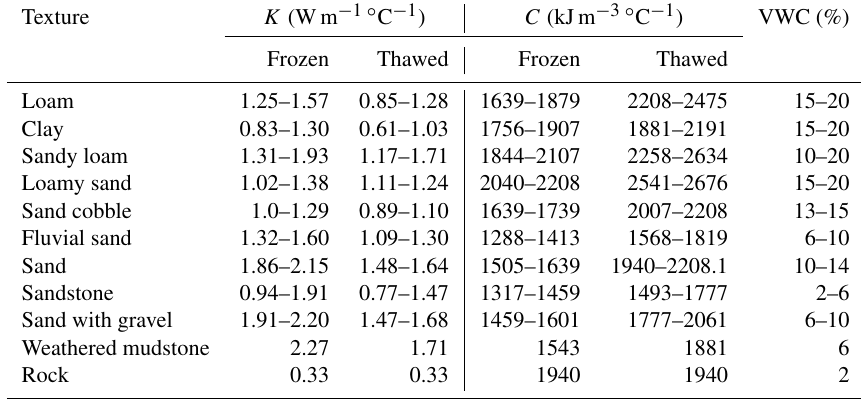
Table A2. Calibration thermophysical parameters of different soil layers used for soil temperature